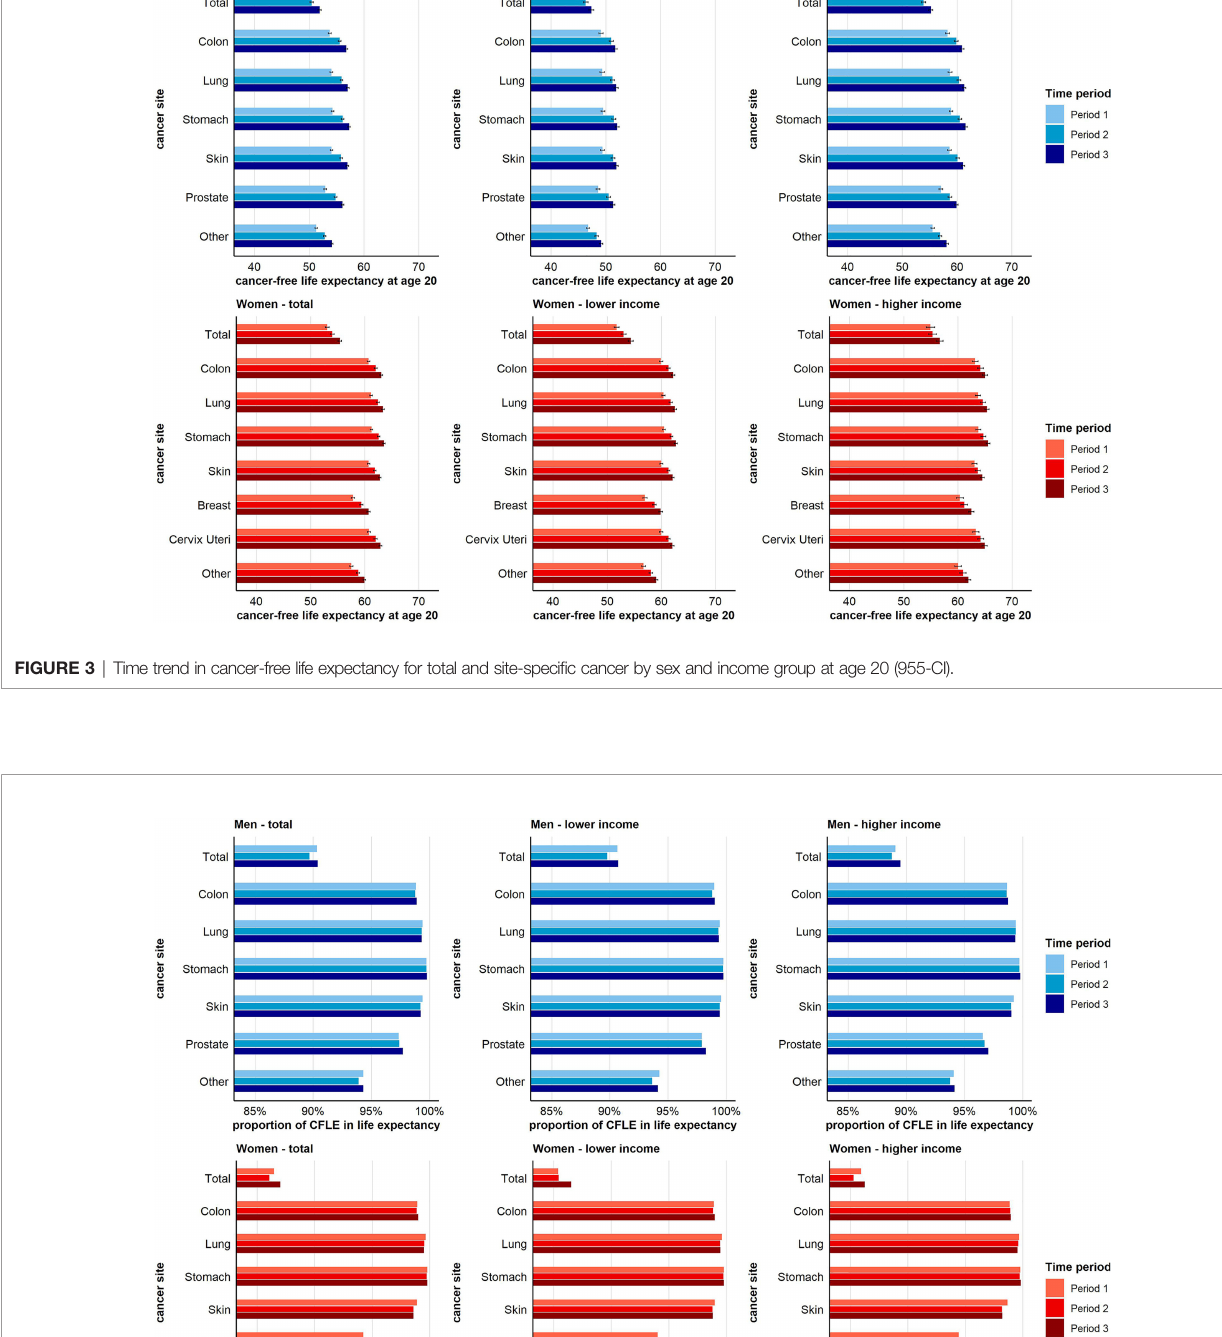
Frontiers in Oncology |